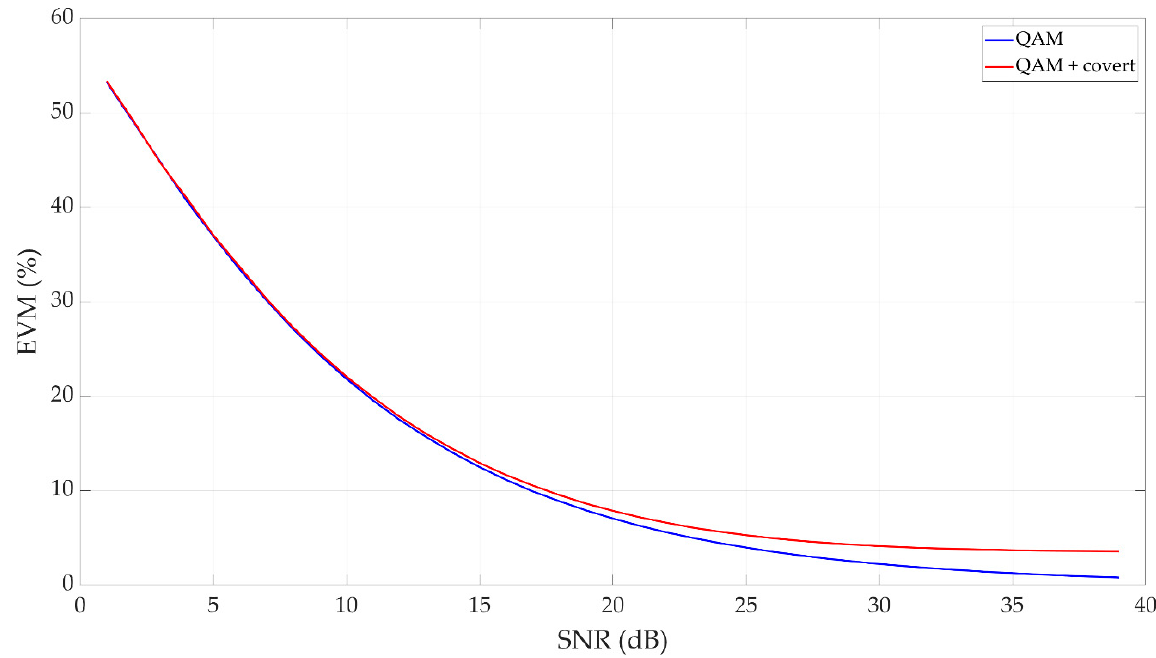
Figure 14. Error vector magnitude ( EVM) versus SNR for cover and covert channel ( K = 30), and random A m .